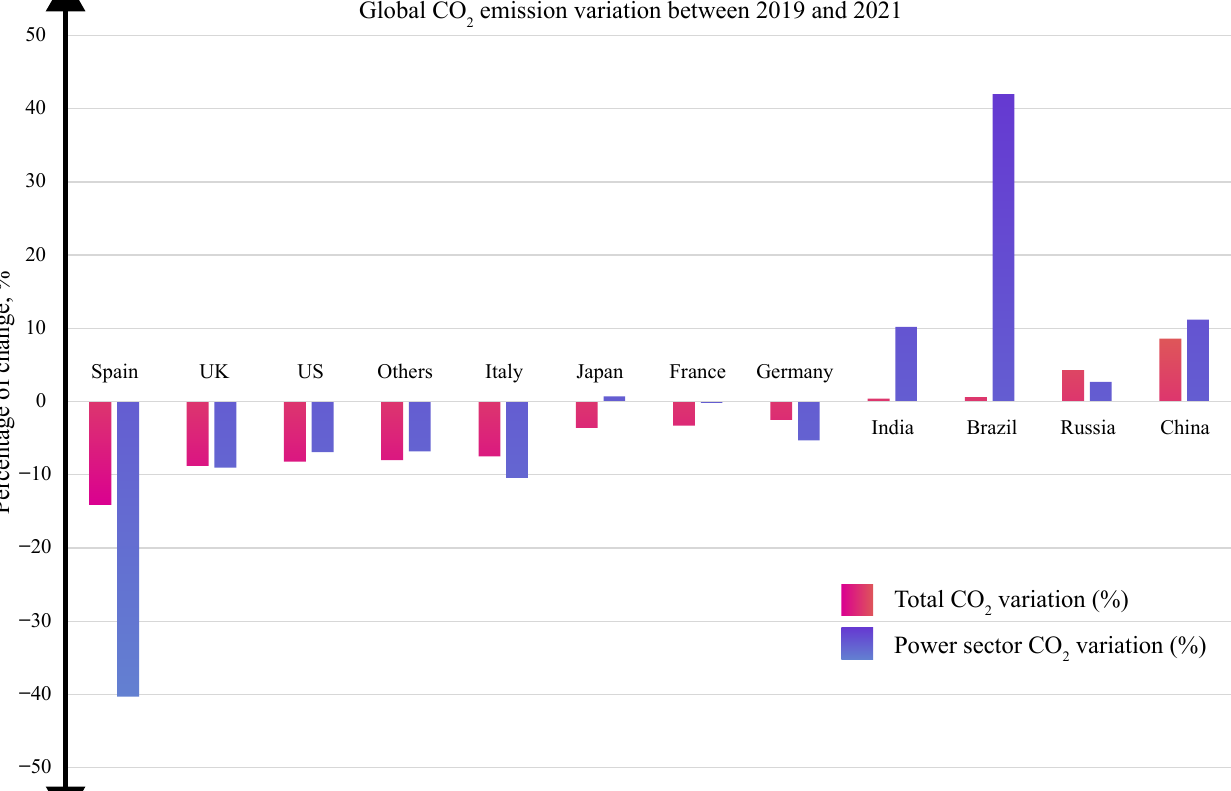
Figure 26. Global variation in CO 2 emissions from the power sector between January 2019 and March 2021 [132]. The U.S.’s total energy-related CO 2 emissions have gone down 15% since their 2007 peak, and the power sector, in particular, has witnessed a 33% reduction in the same time frame. For many years the power sector was the largest emitter of CO 2 , but the adoption of cleaner energy sources led to the gradual decrease in emissions. For the first time in 2016, the power sector dropped to second position and transportation became the largest sector for CO 2 emissions marking a crowning achievement for RESs [133]. The power sector emitted around 1.9 billion tons of CO 2 in 2017, compared to 2.6 billion tons in 2005 indicating a 28% reduction in a decade. This coincides with the reduction of coal’s percentage in the electricity mix from 50% to 30% and the increase of RESs, such as solar and wind, from 2% to 10%, which also took place between 2005 and 2017 [126]. Unlike the desired continuous reduction, the CO 2 emission curve fluctuates each year. This is due to the fact that the power sector is the only sector that managed a momentum shift towards RESs with a sharp increase in wind and solar generation. It is observable from Figure 27 that, compared to the industries, transportation, residential, and commercial sectors, the emissions from the electric power sector achieved a significant reduction in CO 2 equivalent GHG